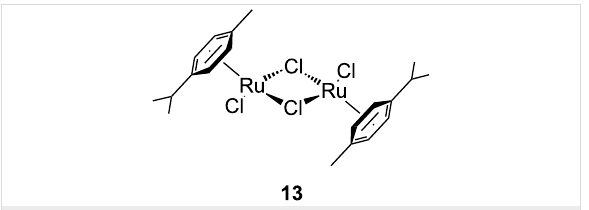
Figure 5: Commercially available photoactive ruthenium